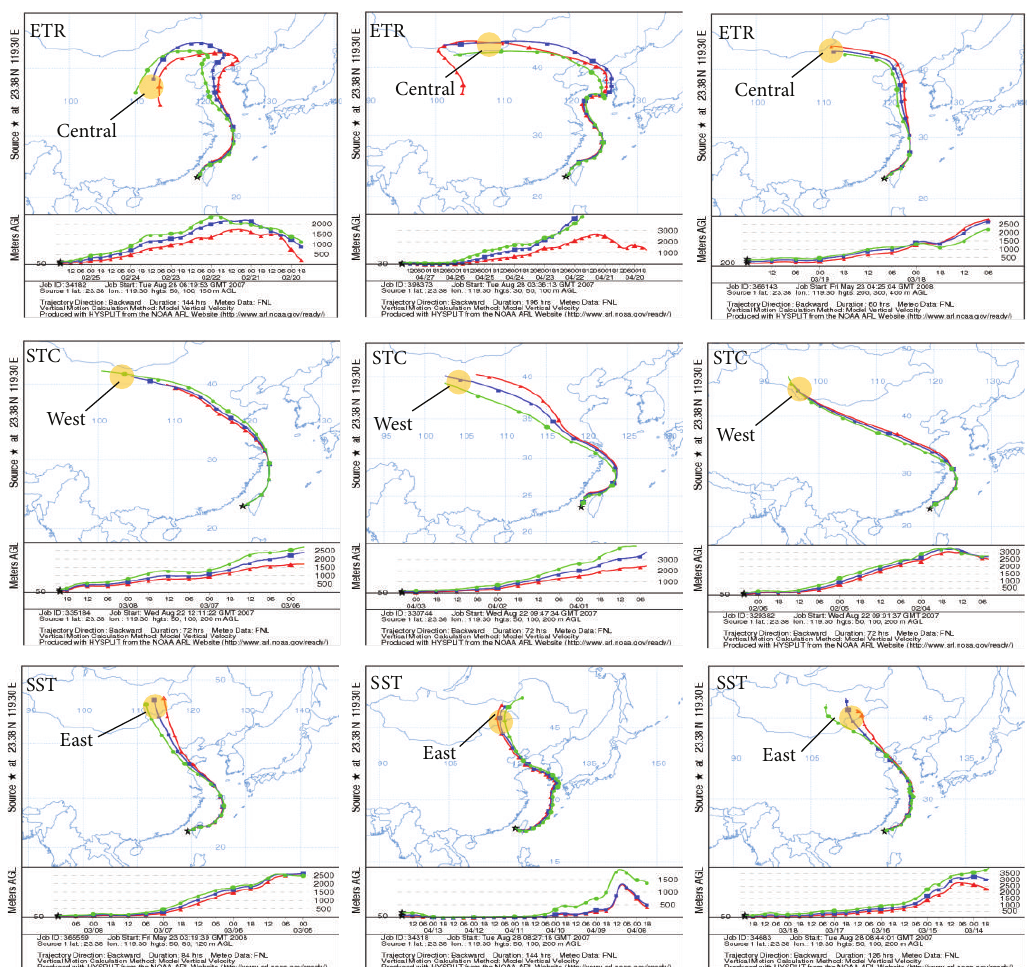
Figure 3: Backward trajectories for three types of ADS transportation routes from the Inner Mongolia to the Pescadores